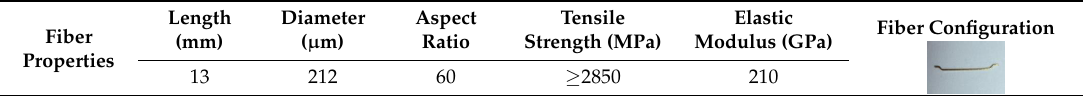
Figure 1. Gradation curves of fine and coarse aggregates. Table 2. Properties and configuration of deformed steel fiber.